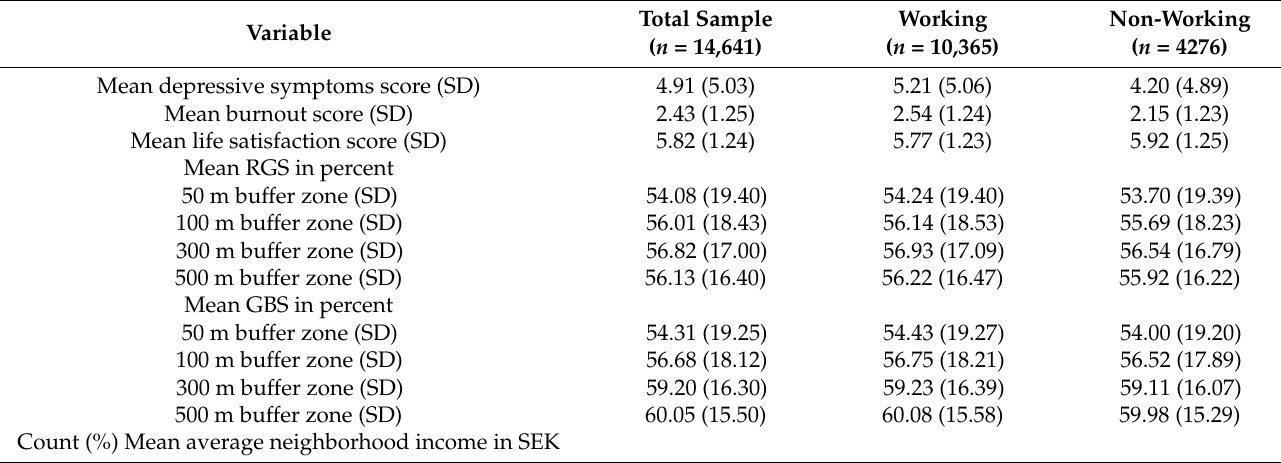
Table 1. Descriptive statistics, mental health outcomes, RGS, GBS, and